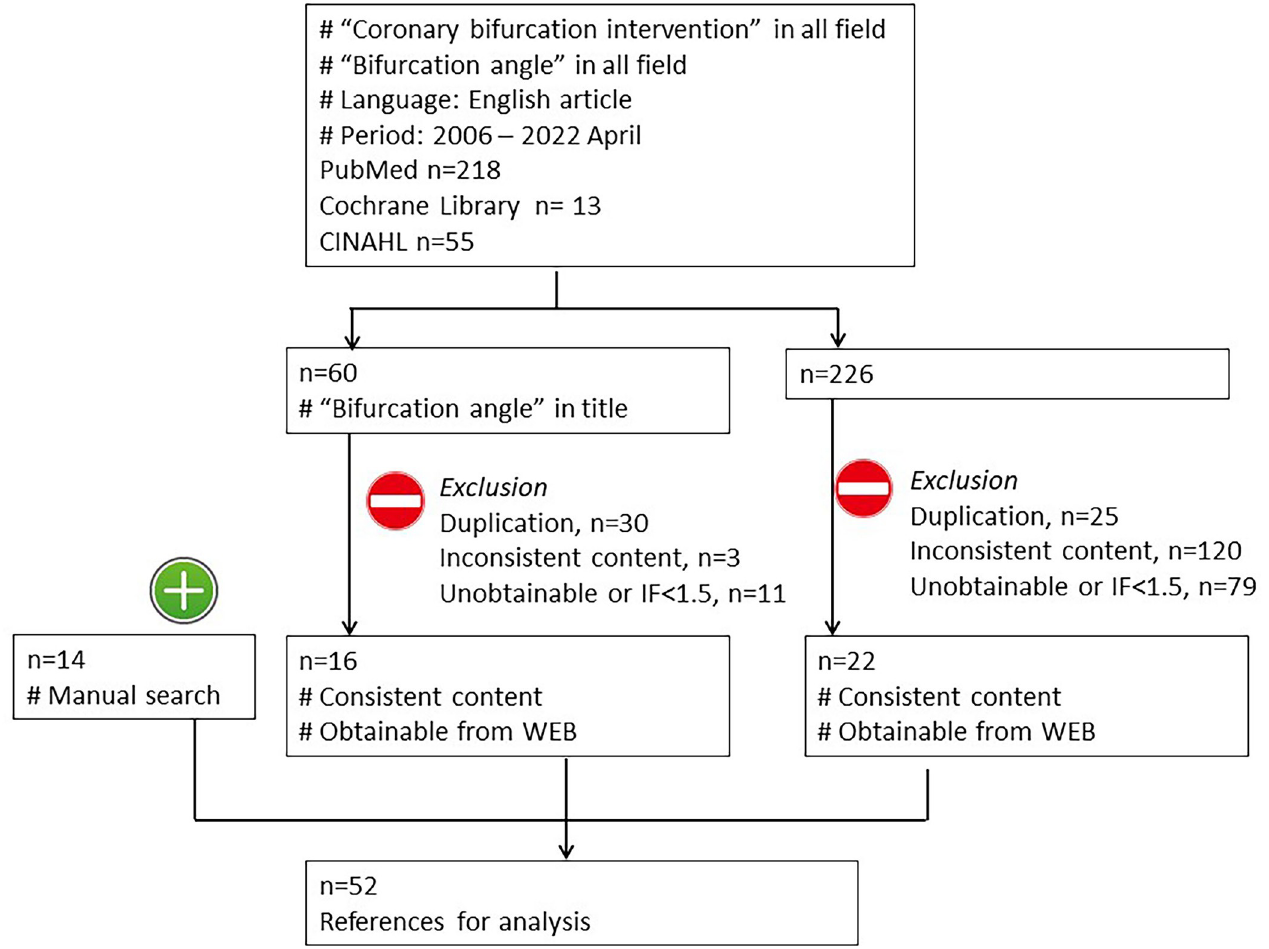
Fig 1. Flow chart of search strategy. IF: Journal impact